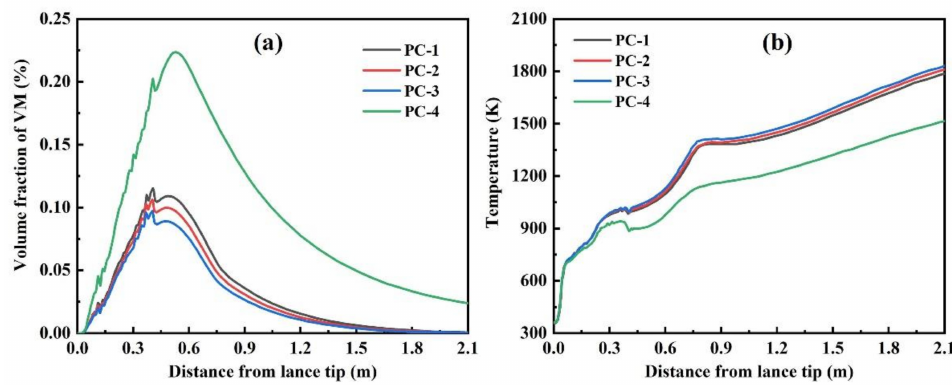
Figure 12. Variation trend of VM volume fraction ( a ) and temperature ( b ) along the tip of the coal lance with different ratios of semi-coke.